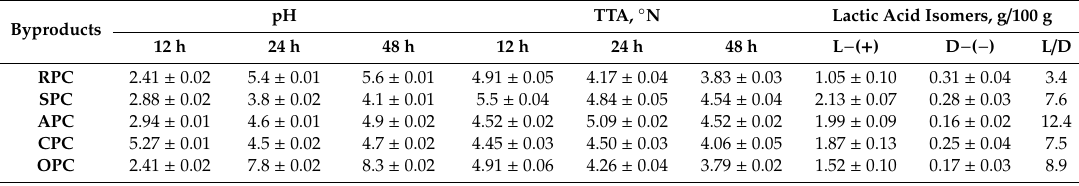
Table 1. Acidity parameters (pH, total titratable acidity, L − ( + ) and D − ( − ) lactic acid concentration) of 12, 24, and 48 h fermented with LUHS210 strain byproducts. pH TTA, ◦ N Lactic Acid Isomers, g / 100 g Byproducts 12 h 24 h 48 h 12 h 24 h 48 h L − ( + ) D − ( − ) L / D RPC 2.41 ± 0.02 5.4 ±